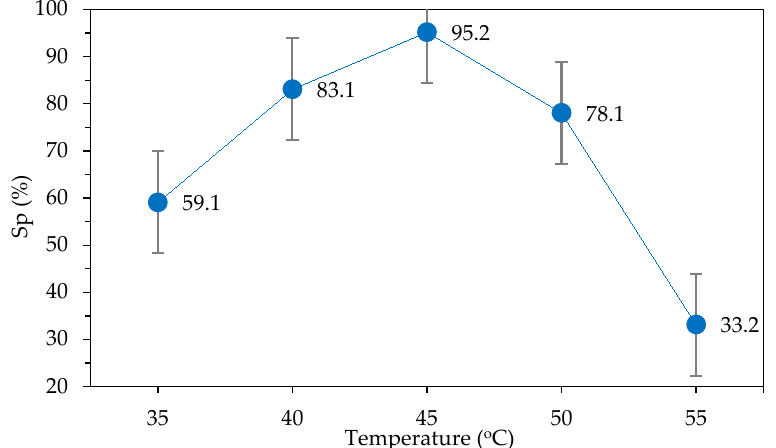
Figure 5. Effect of drying temperature on saponin content.